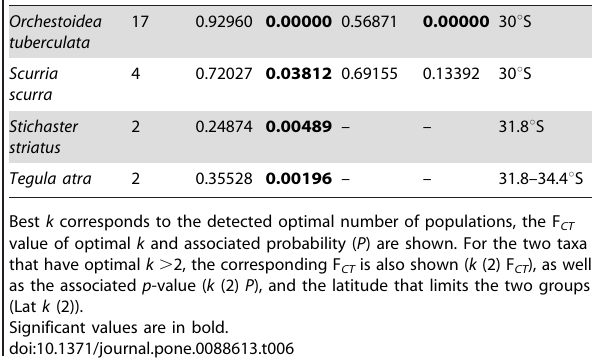
Table 6. SAMOVA of species with spatial genetic structure.